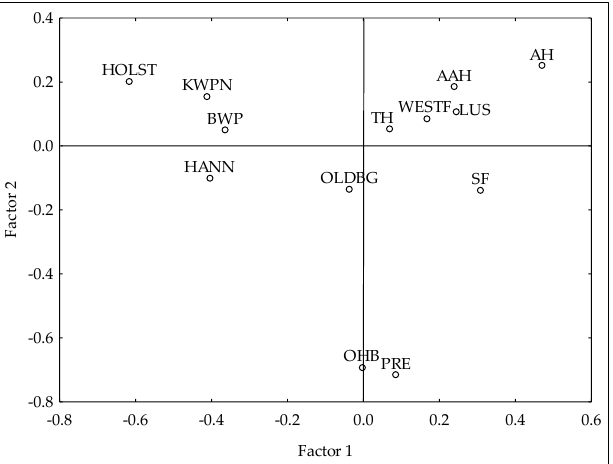
Figure A1. Principal Components Analysis with genealogical information from the horse breeds included in the Official Studbook of the Caballo de Deporte Español horse breed. Where AAH is Anglo-Arab Horse, AH is Arab Horse, BWP is Belgian Warmblood, HANN is Hannoverian Horse, HOLST is Holsteiner Horse, KWPN is KWPN Horse, LUS is Lusitano Purebred, OLDBG is Oldenburg Horse, OHB is Other Horse Breeds, PRE is Pura Raza Española, TH is Thoroughbred, SF is Selle Français and WESTF is Westfalian Horse.